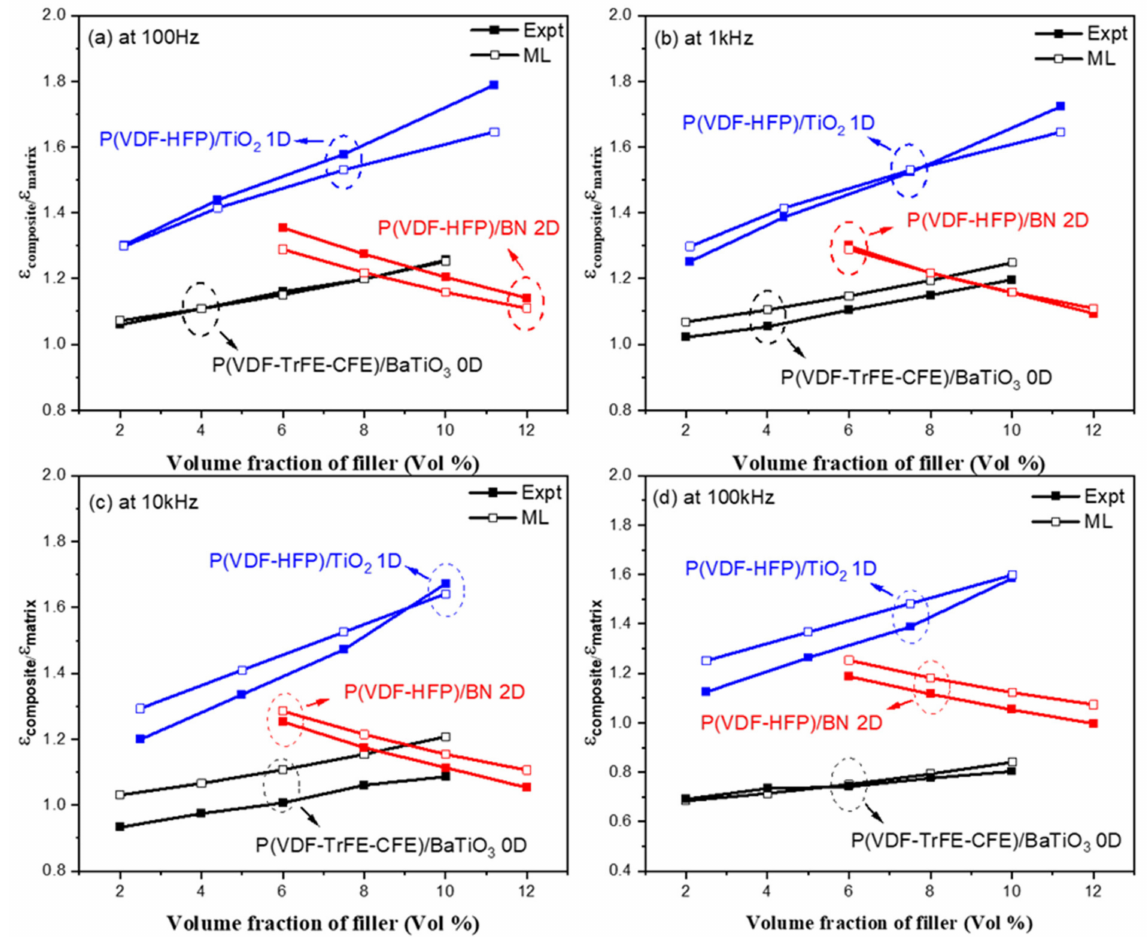
Figure 9. Comparison of experimental and predicted dielectric constant as a function of filler volume fraction depends on increasing frequency: ( a ) 100 Hz, ( b ) 1 kHz, ( c ) 10 kHz, and ( d ) 100